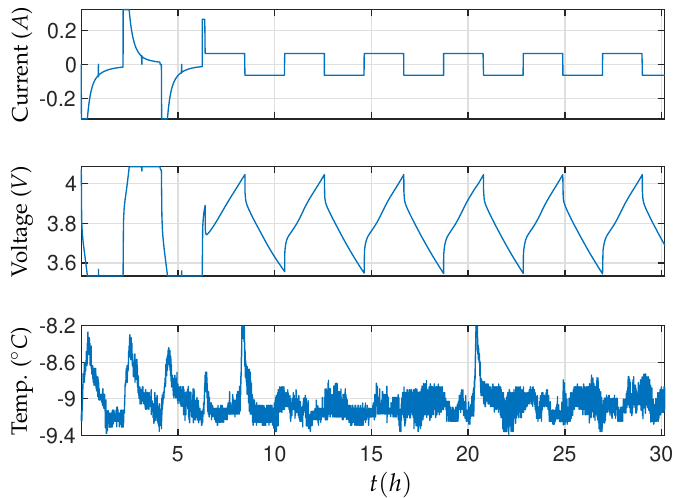
Figure 4. Snapshot of Current, Voltage and Temperature profiles on a section of a load cycle at Figure 4. A snapshot of current, voltage and temperature profiles on a section of a load cycle at low low temperatures with similar charge and discharge pulses. temperatures with similar charge and discharge